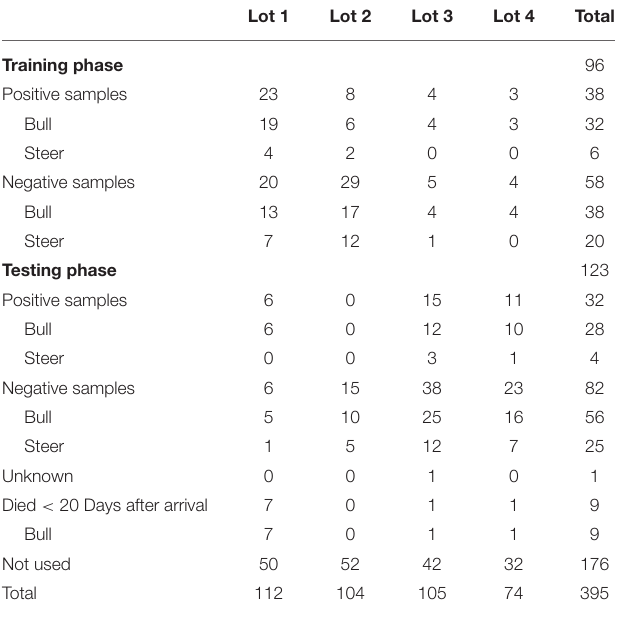
TABLE 2 | Summary of the nasal swab samples that were collected from high-risk cattle upon arrival at the West Texas A&M Research Feedlot by lot, sex, health designation, and use in the training and testing phases of the